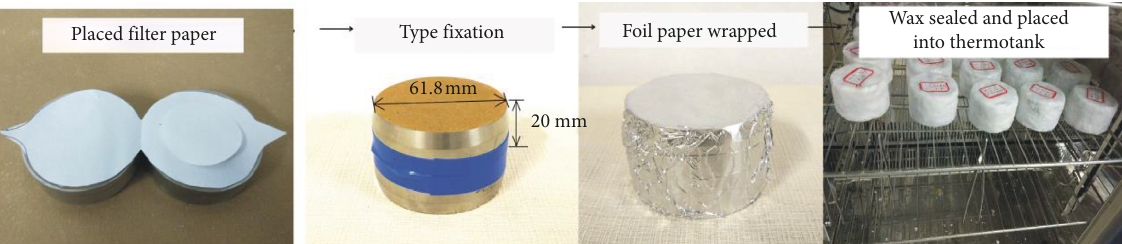
Figure 3: Procedures of the filter paper method.